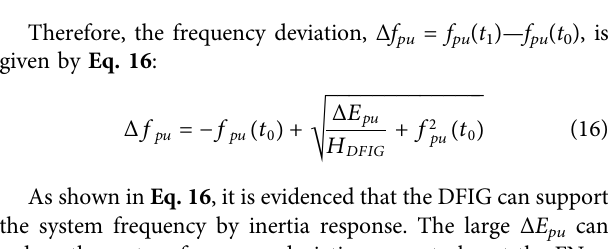
(B) Active power in the time domain. r domain;